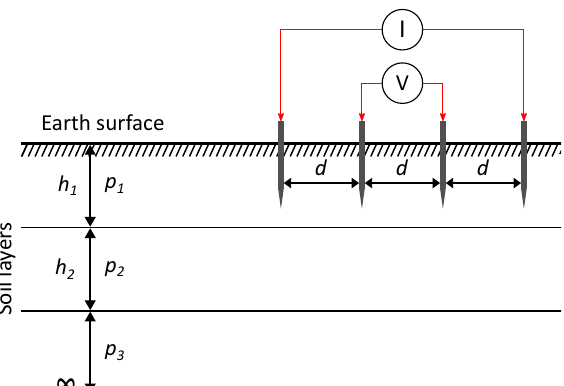
Figure 9. Wenner measuring method and the three-layer soil